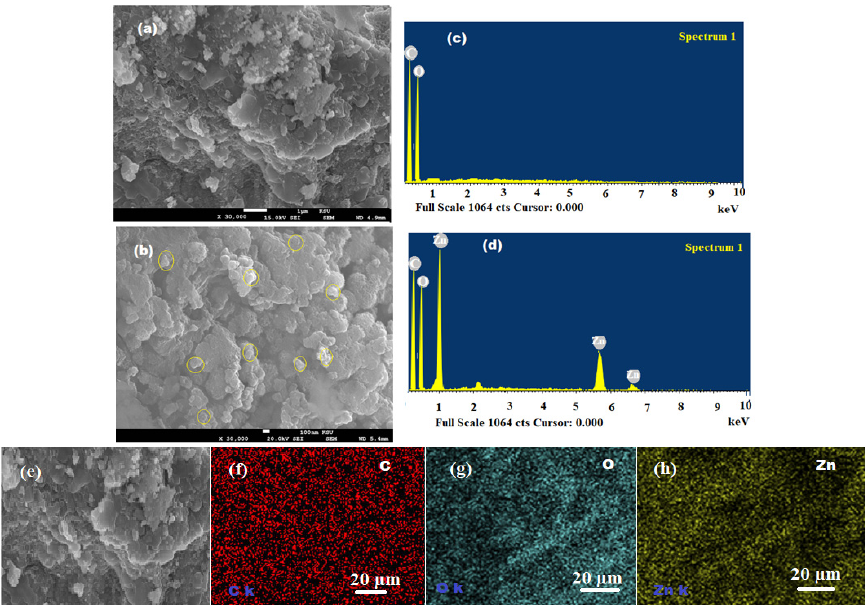
Figure 8. ( a , b ) SEM images of PU and ZnONPs dispersed in the nutmeg oil/PU/ZnONPs polymeric bionanocomposite, ( c , d ) EDX spectra of plain PU and bionanocomposite, and ( e – h ) elemental distribution C-red, O-blue, and Zn-yellow in the EDX mapping of bionanocomposite.